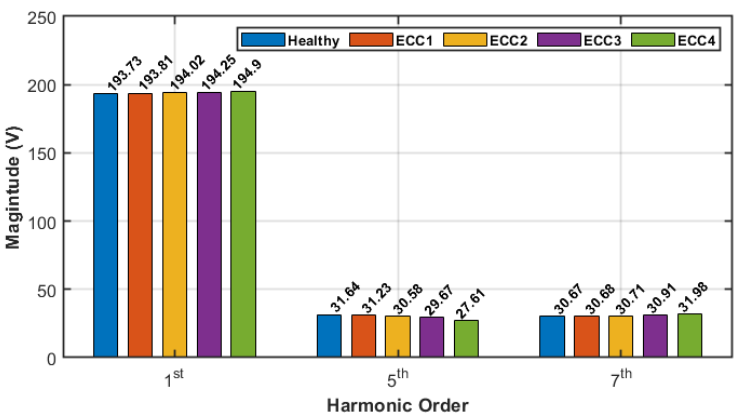
Figure 12. Variations in the harmonic content of stator voltage spectrum for healthy and faulty machine under eccentricity fault in FOC